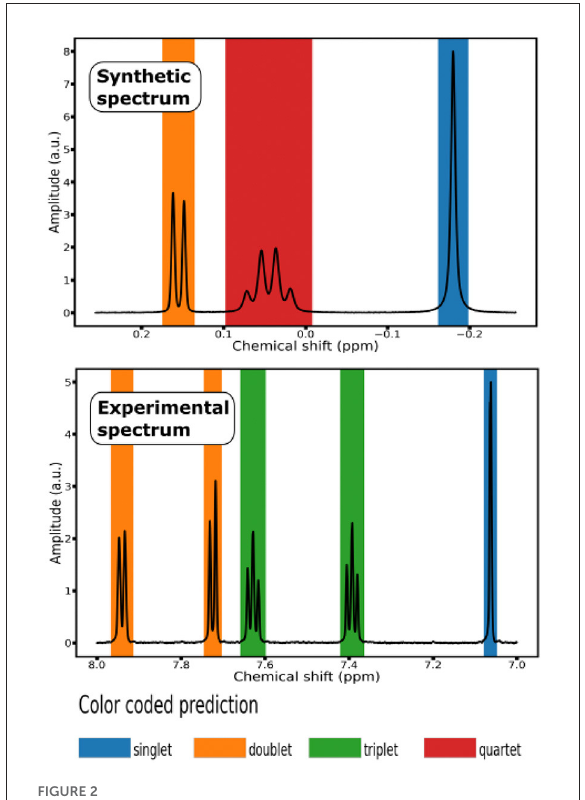
FIGURE2 Color coded prediction of 1 H NMR Spectra: (top) segment of a synthetic spectrum; (bottom) segment of an experimental spectrum from the testing set of 10 small